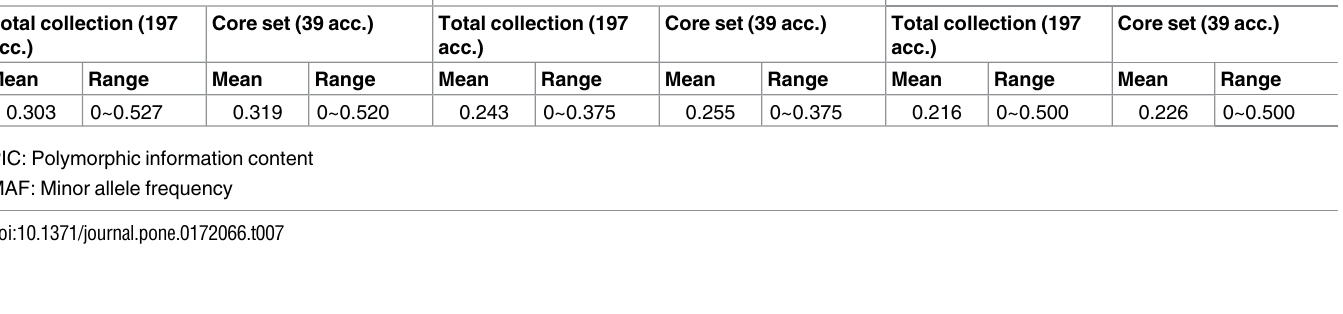
Table 7. Comparison of the genetic diversity of the total collection versus the core set. Genetic distance PIC MAF Total collection (197 Core set (39 acc.)